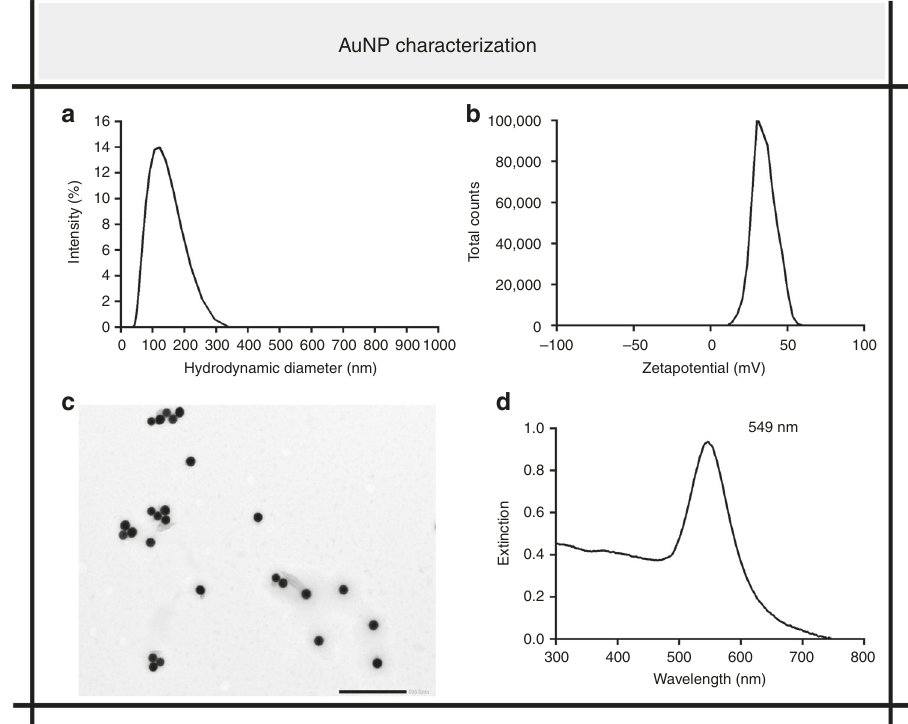
Fig. 2 AuNP characterization. a, b Size distribution ( a ) and zeta potential ( b ) of AuNP, as determined by DLS. c Morphological spherical structure of AuNP, visualized by TEM. Scale bar = 500 nm. d UV – VIS spectrum of AuNP revealing a localized plasmon resonance peak at 549